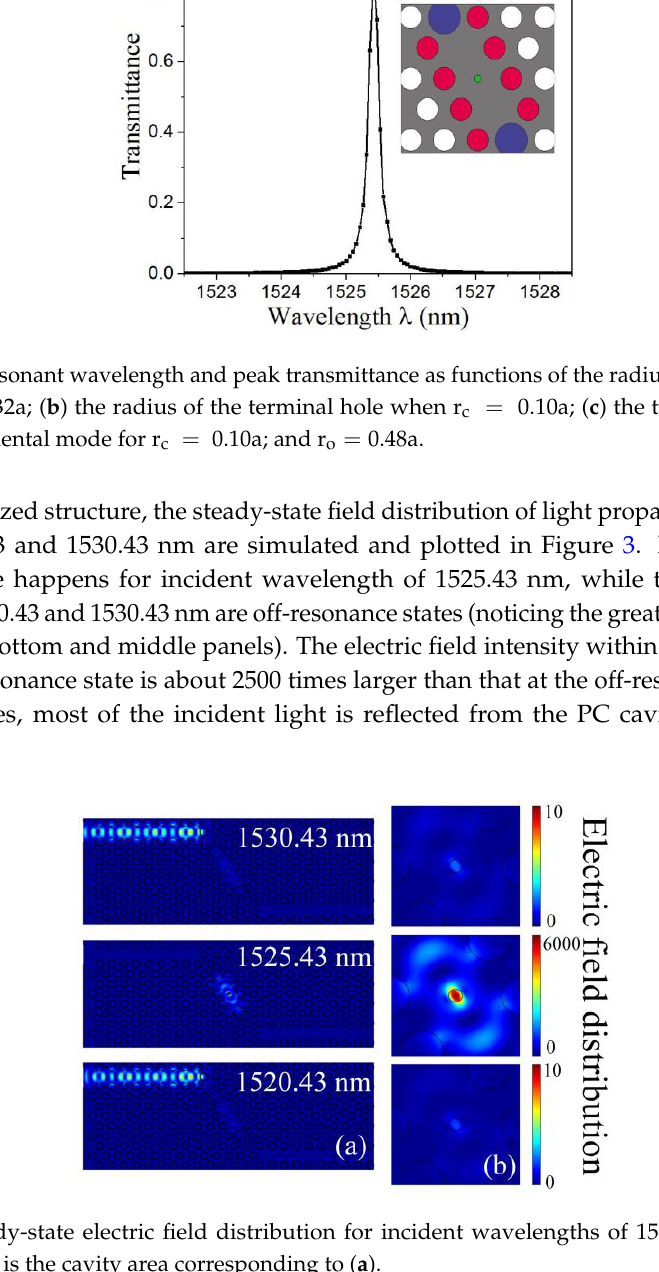
Figure 3. Steady-state electric field distribution for incident wavelengths of 1530.43, 1525.43 and 1520.43 nm. ( b ) is the cavity area corresponding to ( a ). 1520.43 nm. ( b ) is the cavity area corresponding to ( a